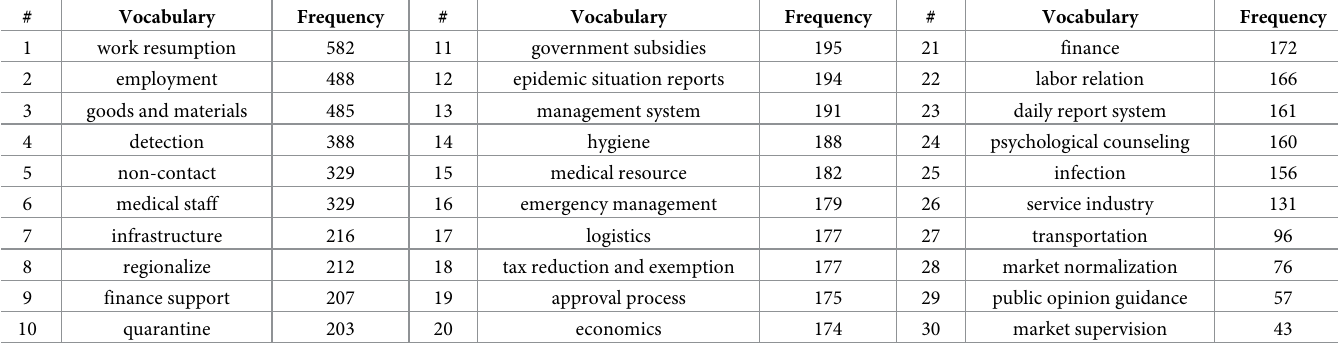
Table 3. Statistics of valid vocabulary and word frequency in policy